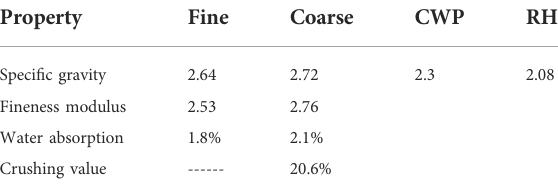
TABLE 3 Physical properties of aggregate, CWP, and RHA.